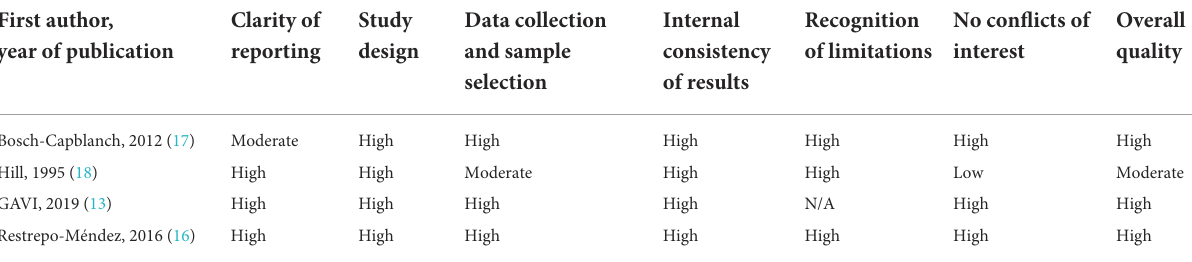
TABLE 1 Risk of bias assessment results after using the AXIS